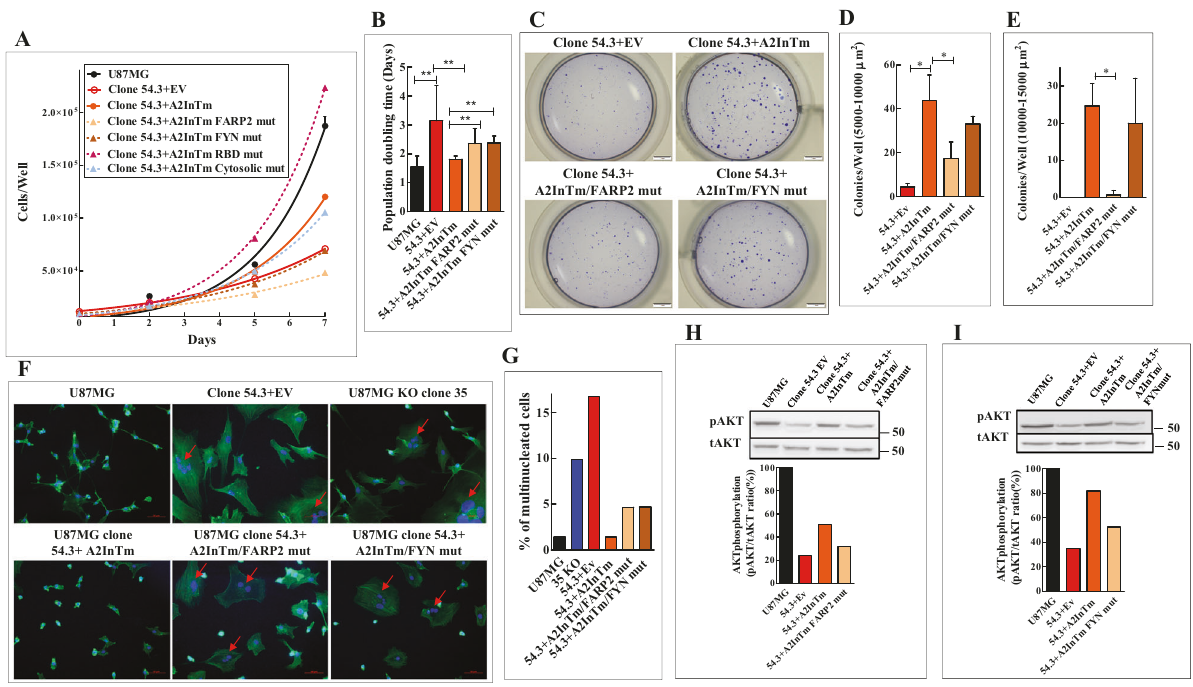
Fig. 7 Point mutations in the FARP2 binding site and in the Fyn phosphorylation sites of the plexin-A2 intracellular domain inhibit restoration of cell proliferation induced by A2InTm and inhibit the A2InTm mediated rescue of AKT phosphorylation. A U87MG cells, U87MG clone 54.3 cells infected with either control lentiviruses (EV) or with lentiviruses encoding A2InTm or A2InTm variants containing point mutations in the FARP2 binding site (54.3 + A2InTm FARP2 mut), in the Fyn phosphorylation sites (54.3 + A2InTm FYN mut), in the Rho binding domain (RBD) (54.3 + A2InTm RBD mut) or in the juxtamembrane cytosolic dimerization interface (54.3 + A2InTm Cytosolic mut) of plexin-A2 were seeded in 24 well dishes (1 × 10 4 cells/well). Triplicate wells were counted every two days using a coulter-counter. Data